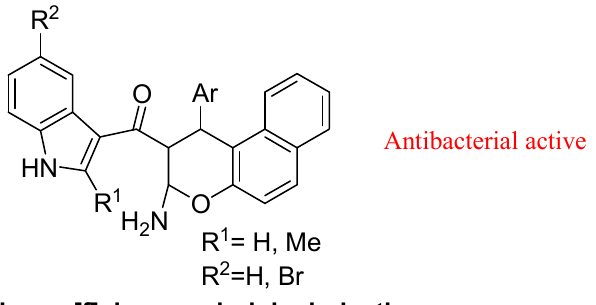
Figure 27. Functionalized indole-substituted chromene